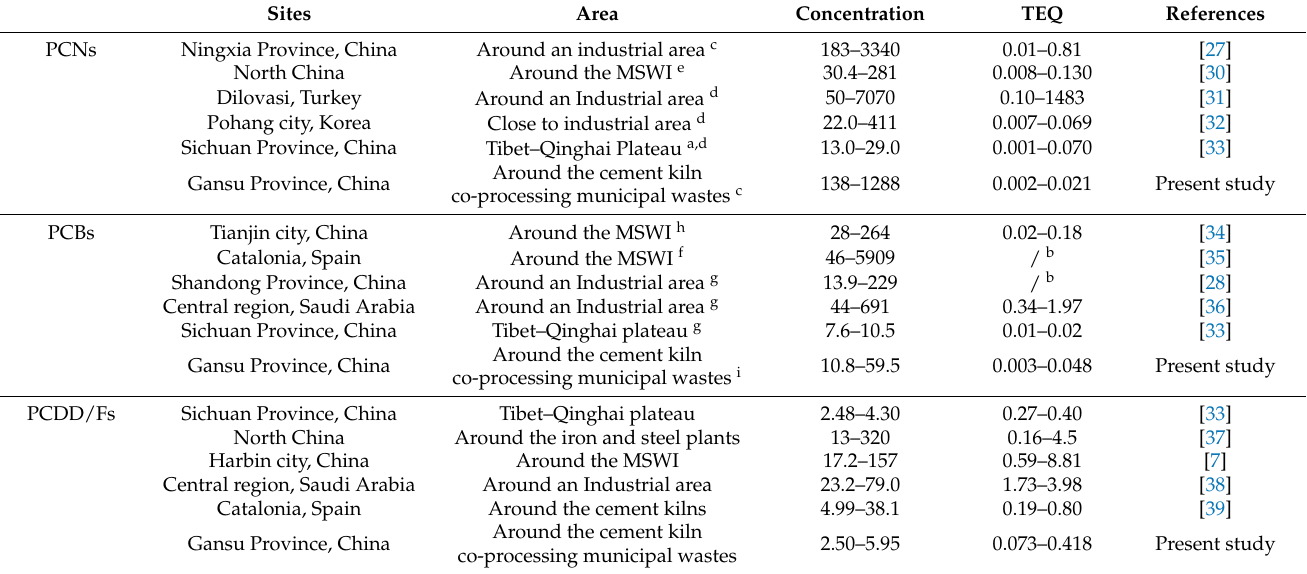
Table 2. Soil POP concentrations (pg/g) and TEQ (pg WHO-TEQ/g) were reported in previous